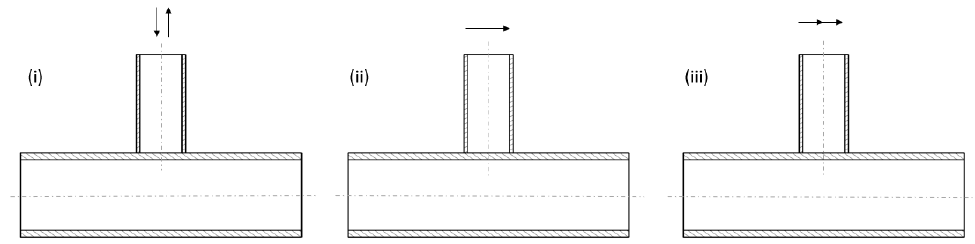
Figure 2. Possible loads on tubular joints. ( i ) Axial tensile/compressive, ( ii ) in-plane bending, ( iii ) out-of-plane bending.